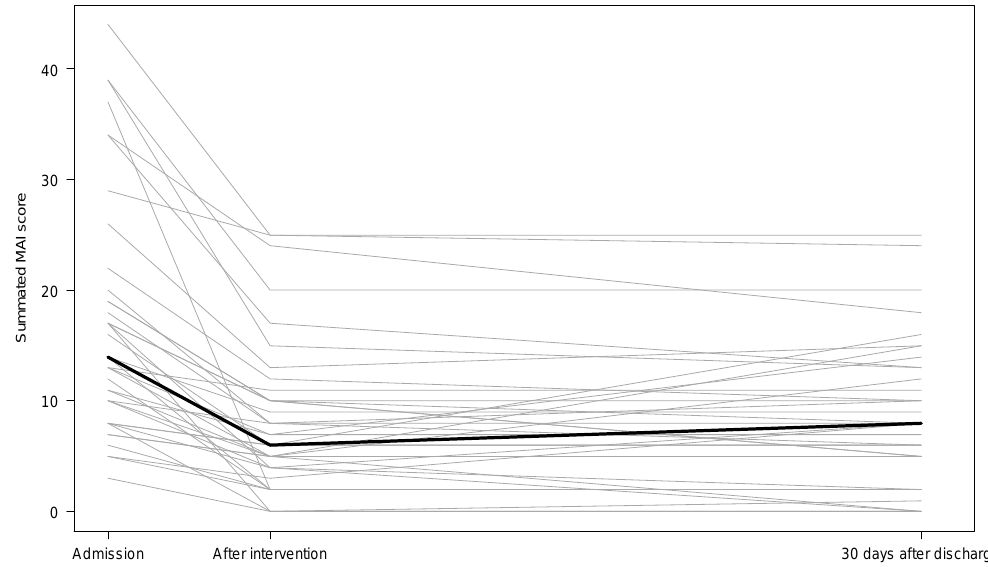
Figure 2. Summated Medication Appropriateness Index (MAI) scores at admission, after intervention, and at 30 days after discharge ( n = 39). Light grey lines represent each patient, solid black line is the median.